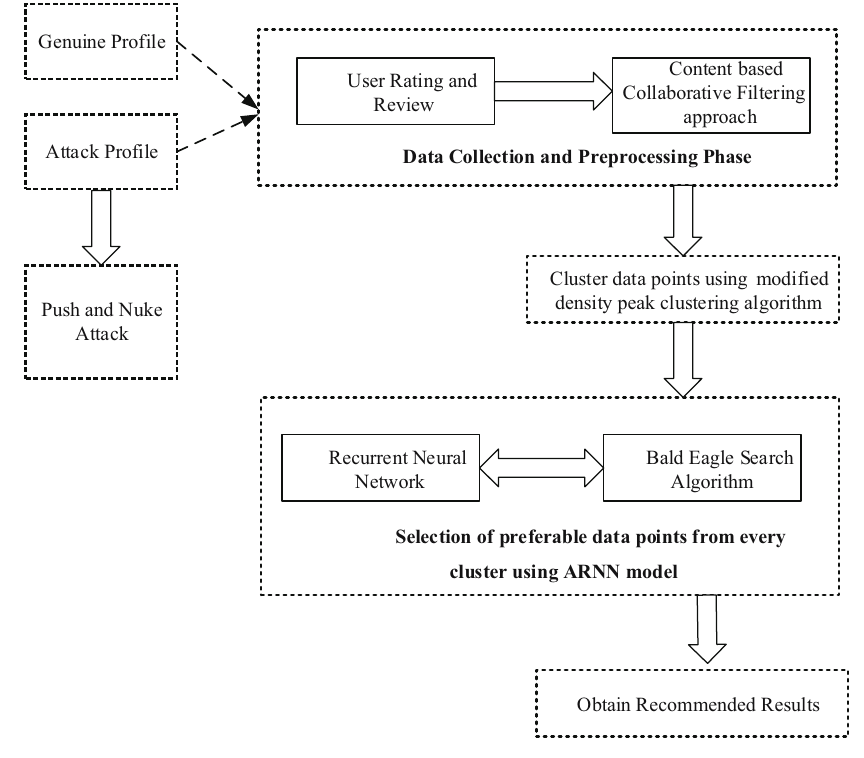
Figure 3: Proposed framework for HRS using the ARNN